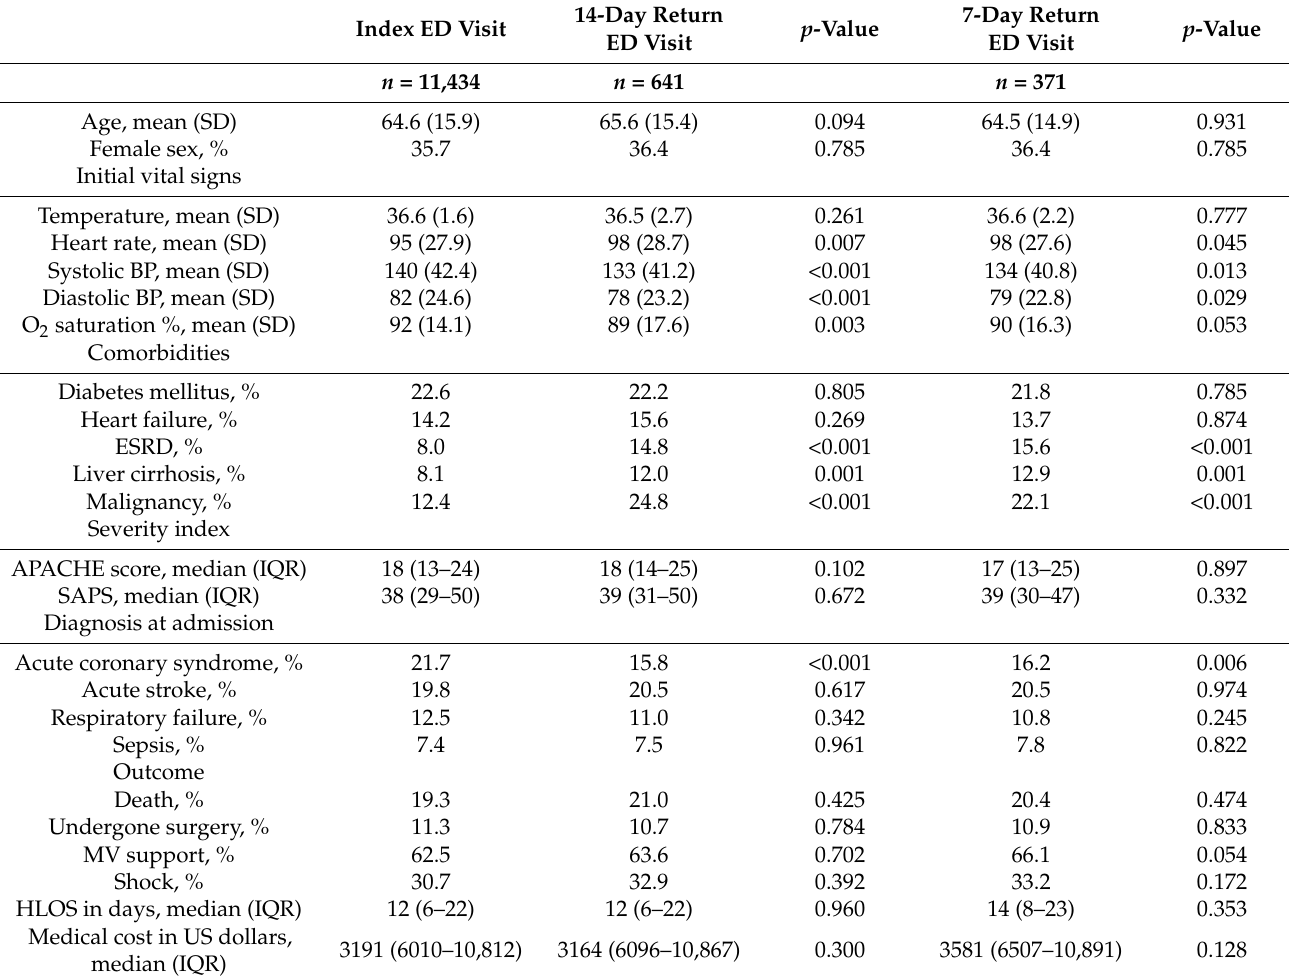
Table 1. Demographics, clinical characteristics, and in-hospital outcomes of patients admitted to the ICU following an index ED visit, 14-day return ED visit, and 7-day return ED visit.